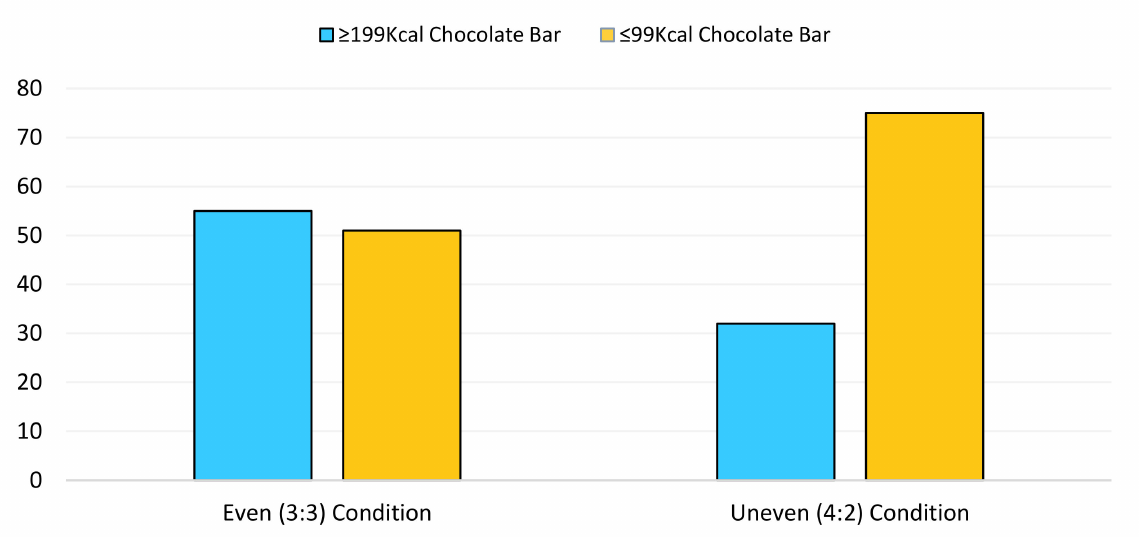
Figure 2. The number of 99 kcal (depicted in orange) and 199 kcal (presented in blue) chocolate bar selections made across the even (3:3 availability) and uneven conditions (4:2 availability in favour of the 99